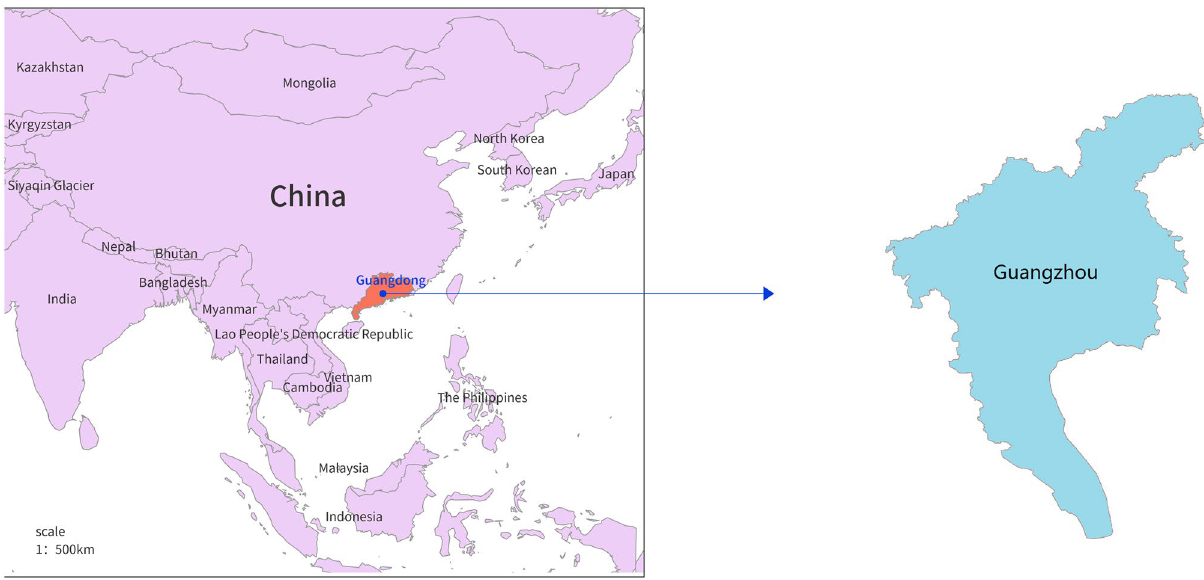
Figure 1. The location of Guangzhou. The blue dot indicates the location of Guangzhou in China. The map was created using ArcGIS9.3, URL: http:// www. esric hina- bj. cn.